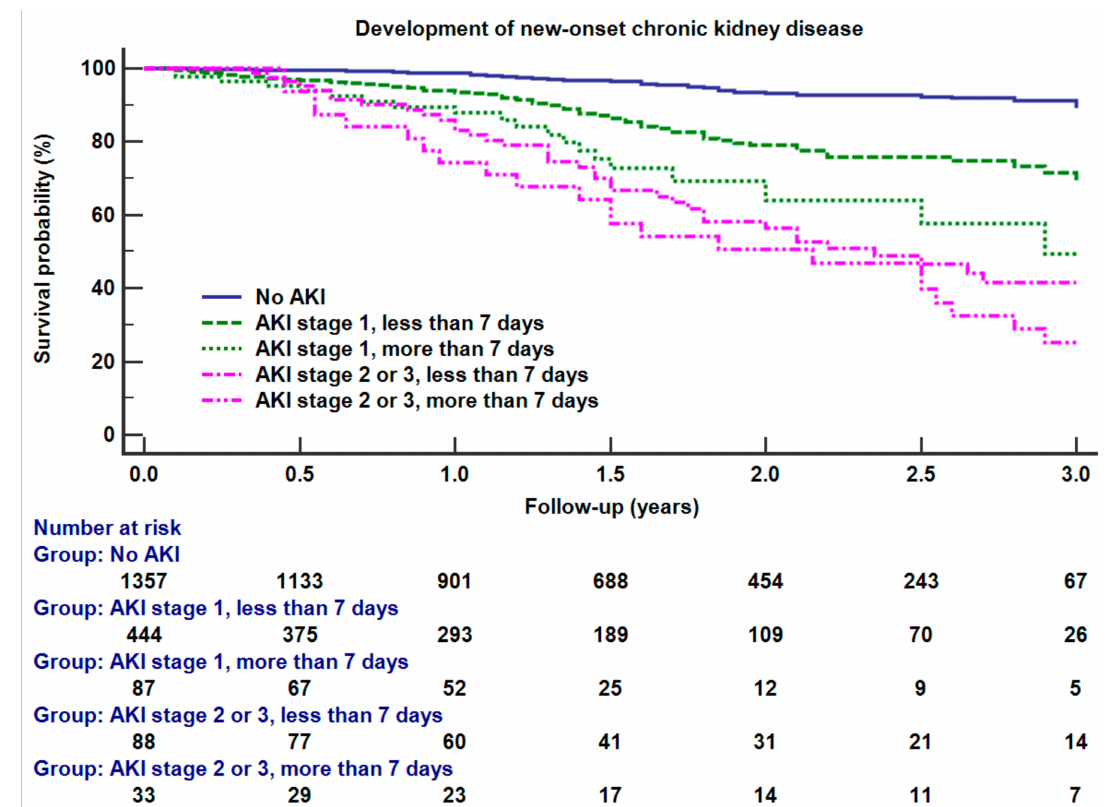
Figure 3. Kaplan–Meier survival curve analysis between different groups of acute kidney injury (AKI), i.e., no AKI, AKI stage 1 lasting less than seven days, AKI stage 1 lasting more than seven days, AKI stage 2 or 3 lasting less than seven days, AKI stage 2 or 3 lasting more than seven days. There were significant differences in survival between different AKI groups (log-rank test p <